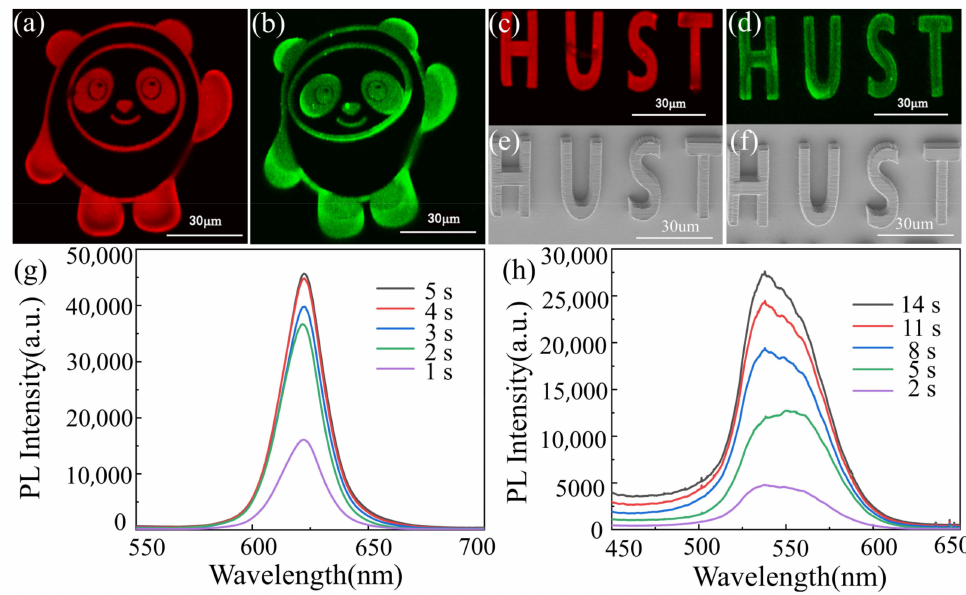
Figure 6. The fluorescence images of the DLW processed 5 mg/mL red QD–polymer microstructure of 2D bingdundun, 3D hust ( a , c ), as well as 5 mg/mL green QD–polymer microstructure of 2D bingdundun, 3D hust ( b , d ); FE-SEM images of the DLW processed 5 mg/mL red QD–polymer 3D hust ( e ) and 5 mg/mL green QD–polymer 3D hust ( f ); PL emission spectra of the DLW processed 5 mg/mL red QD–polymer microstructure ( g ) and 5 mg/mL green QD–polymer microstructure ( h ) with an excitation wavelength of 325 nm at various exposure